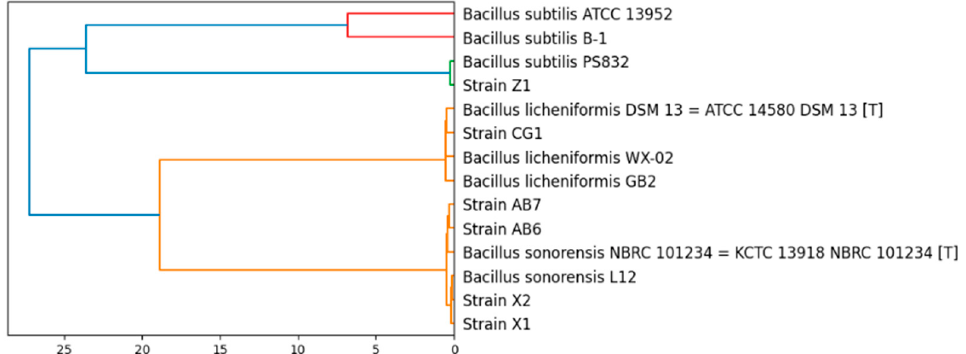
Figure 1. Phylogenetic relations of the isolated strains with strains of the species B. subtilis , B. sonorensis and B. licheniformis .